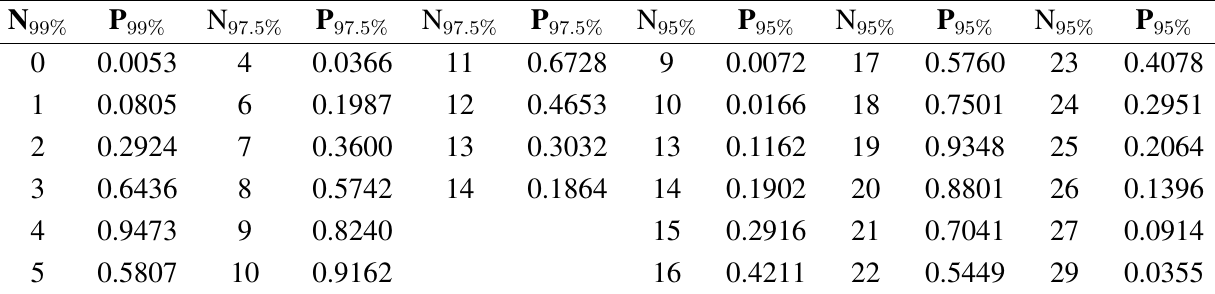
Table 3. P value of Kupiec backtesting procedure for the range of exceedance values.